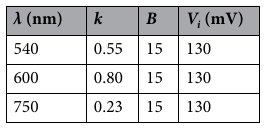
Table 1. Fitting parameters of IPCEs varying with bias at different